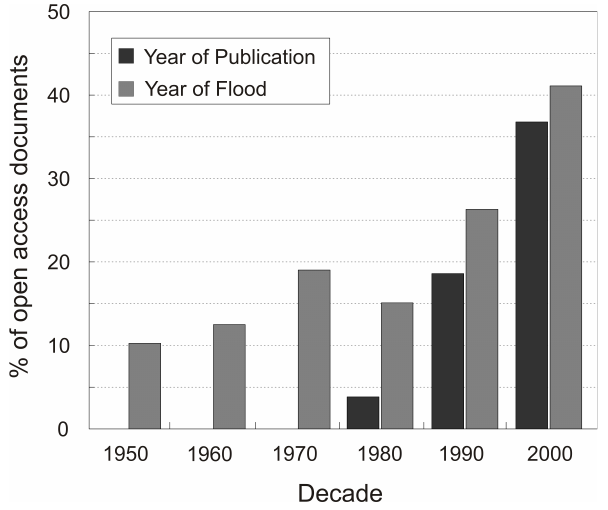
Fig. 2. Percentage of documents with open access to the full text, aggregated into decades (2000 only accounting for 3yr, 2000–2002) considering (a) the year when the document was published and (b) the flood event